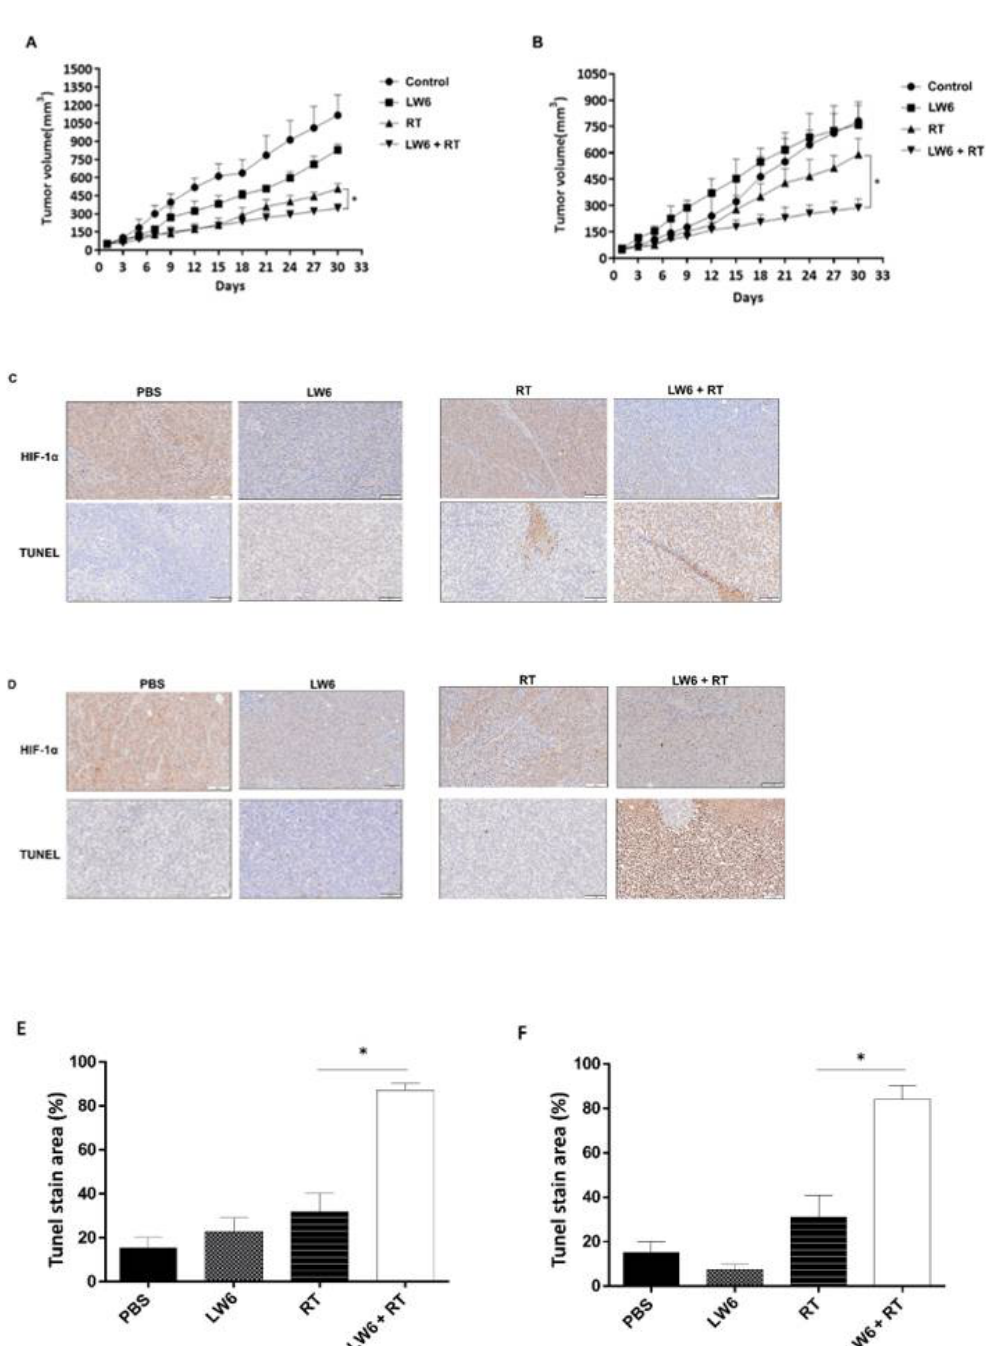
Figure 6. Analysis of the effect of combined LW6 on the radiation of hyperglycemic rectal cancer. Hyperglycemic ectopic rectal cancer was treated with LW6, radiation, or combined LW6 with radiation. The tumor volume was measured every two days until day 30 ( A , B ). Rectal cancer masses were removed and collected subcutaneously after the measured endpoint, immunohistochemically analysis of HIF-1 α expression, and Tunel assay in HCT116 ( C ) or SW480 ( D ). Tunel staining statistics ( E , F ) in HCT116 and SW480, respectively. Data are presented as mean ± SD ( n = 4; * p <